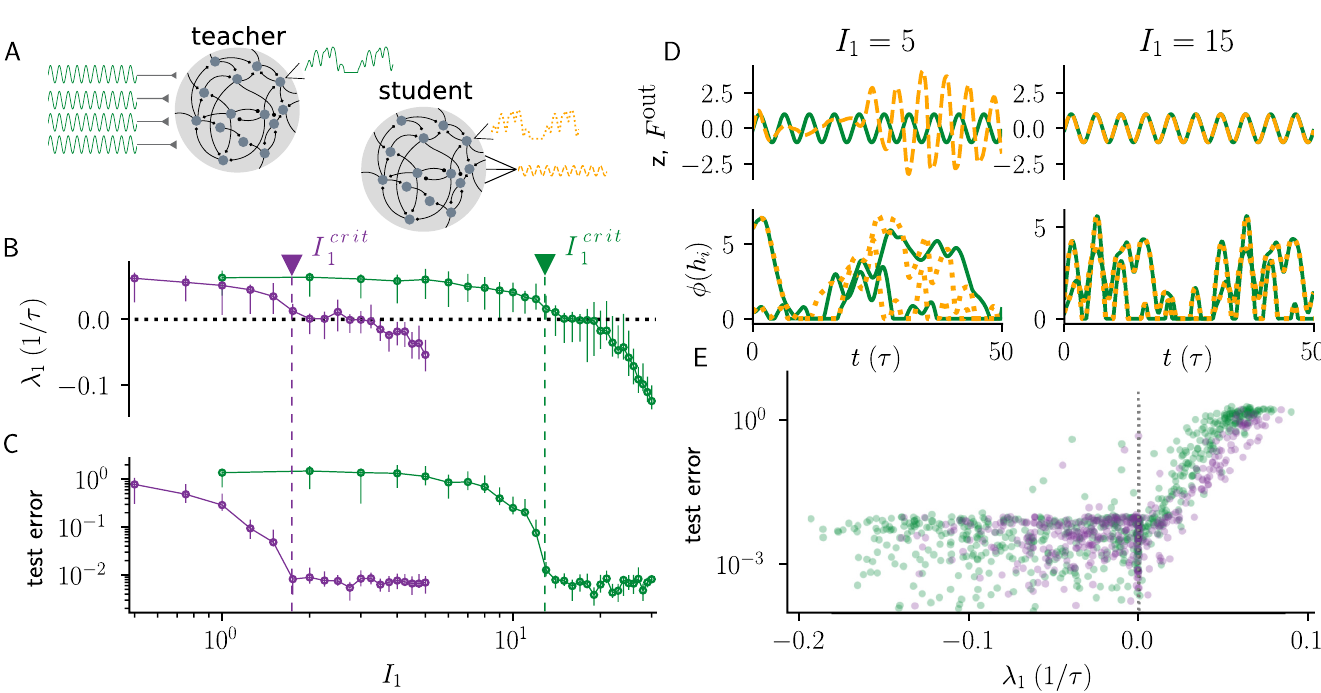
Fig 7. Common input impedes learning in balanced networks. A) Schematic of the training setup. A ‘student network’ (S) is trained to autonomously generate the output F out ð t Þ ¼ sin ð 2 p ft Þ , by matching its recurrent inputs to those of a driven ‘teacher network’, whose weights are not changed during training. B) λ 1 in the teacher network as a function of I 1 . C) Test error in the student network as a function of I 1 . Critical input amplitude I crit is indicated by vertical dashed lines. Consistent with 1 the difference in I crit , the teacher networks driven with common input require a larger I 1 to achieve small test errors in the student network. Error bars indicate 1 interquartile range around the median. D) Top: Target output F out (green) and actual output z (dashed orange) for two input amplitudes I 1 2 {5, 15}. Bottom: Firing ) for two example neurons in teacher network with common input (green full line) and student network (orange dotted line) for two input amplitudes. E) rate ϕ ( h i Scatter plot of test error as a function of λ 1 for each network realization in A and B , with both common and independent input. When chaos in the teacher network is not suppressed ( λ 1 > 0), test error is high. Training is successful (small test error) when targets are strong enough to suppress chaos in the teacher network. Training is terminated when error reaches below 10 − 2 . Model parameters: N = 500, g = 2, I 0 = J 0 = 1, ϕ ( x ) = max( x , 0) in both teacher and student networks; f = 0.2/ τ in the teacher network inputs and target F out